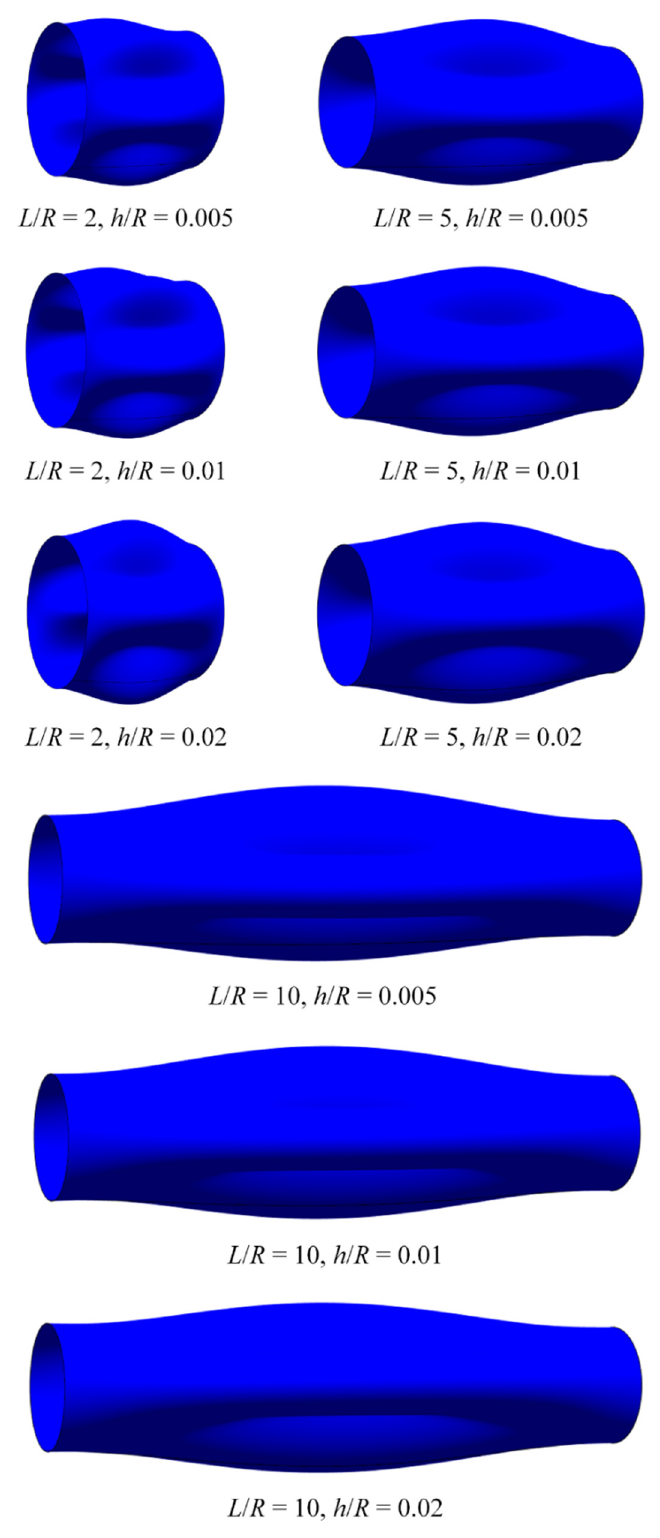
Figure 8. Buckling modes of ring-stiffened porous GPLRC cylindrical shells for different thickness– radius ratios and length–radius ratios.